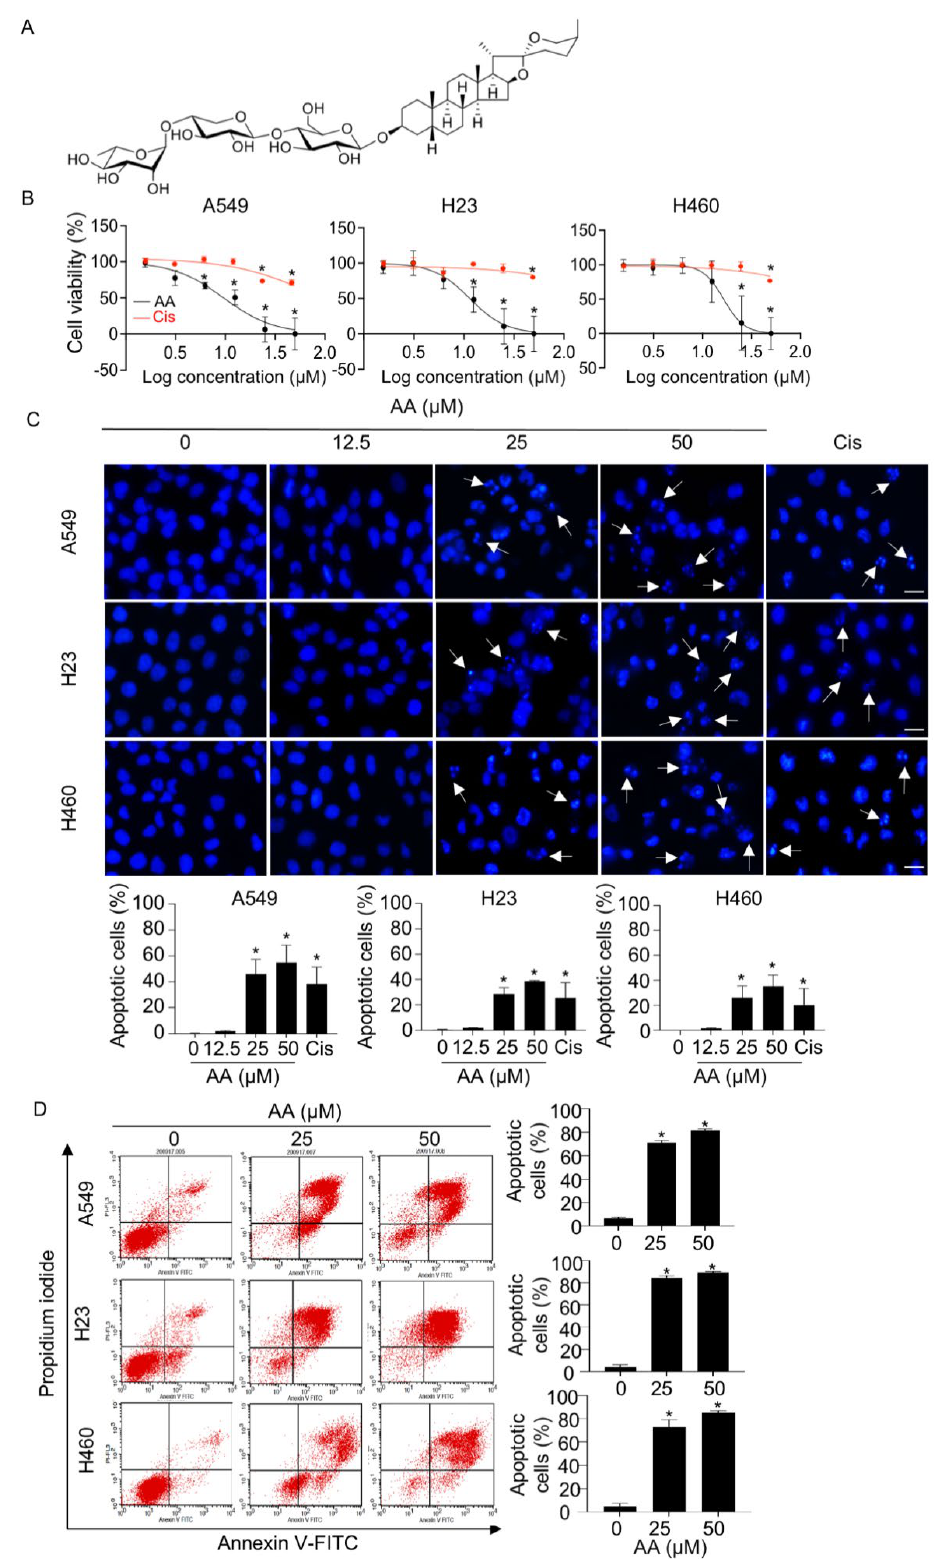
Figure 1. Apoptosis-inducing effect of aspiletrein A (AA) in lung cancer cells. ( A ) Chemical structure of AA. ( B ) Lung cancer A549, H23, and H460 cells were treated with either AA (0–50 μM) or cisplatin (Cis, 0–50 μM) for 24 h. Cell viability was determined via MTT assay and presented as a percentage.